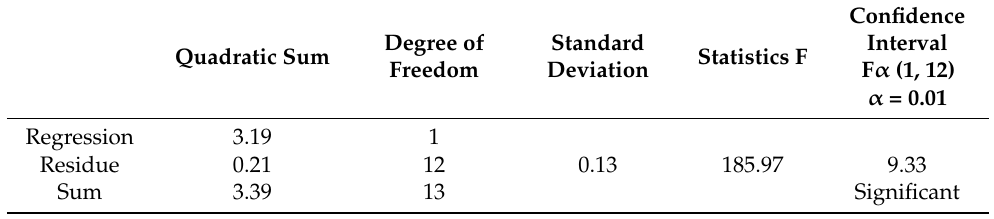
Table 9. Significance test of CSG fatigue